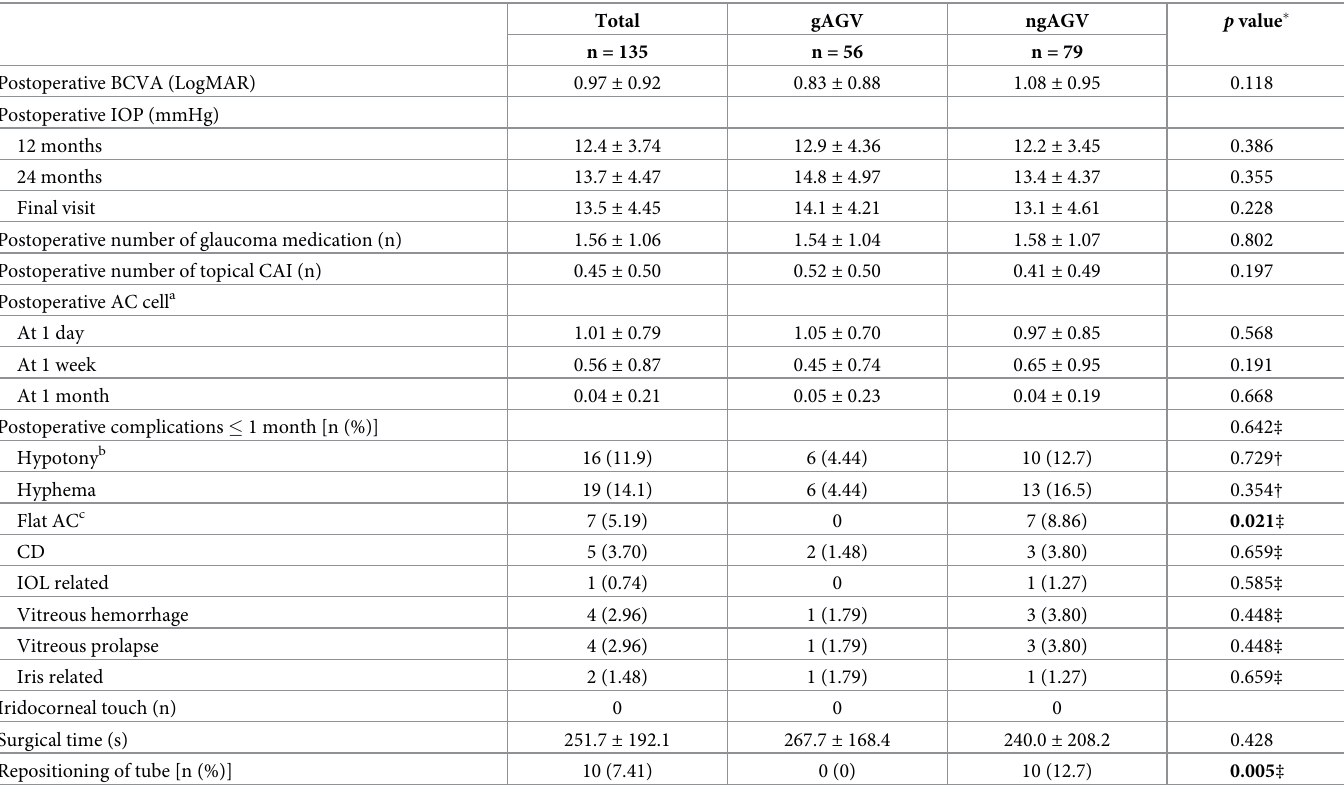
Table 2. Comparison of surgical results after guided and non-guided Ahmed glaucoma valve